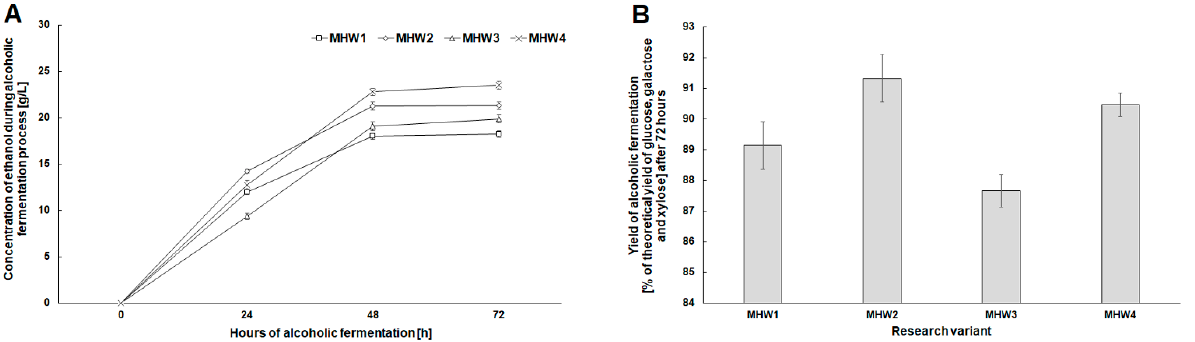
Figure 6. Changes in the concentration of ethanol during alcoholic fermentation ( A ), and alcoholic fermentation yield relative to the theoretical one after 72 h of the process ( B ) for pretreated wheat stillage concentrations of 143 and 167 g/L.